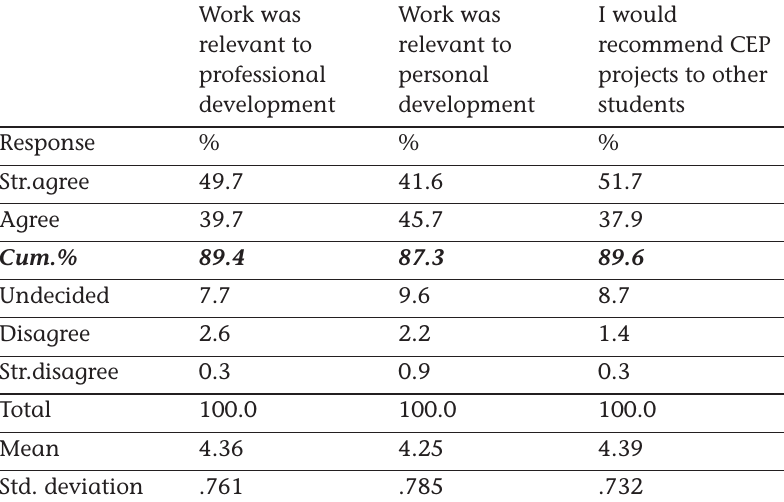
Table 2: Summary of student evaluation responses,